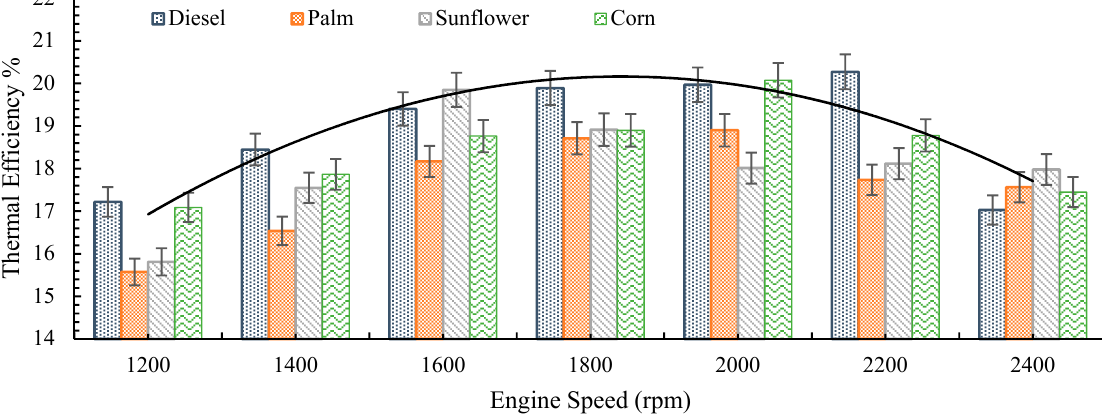
Figure 7. Variation of thermal efficiency vs. engine speed for different biodiesel blends.